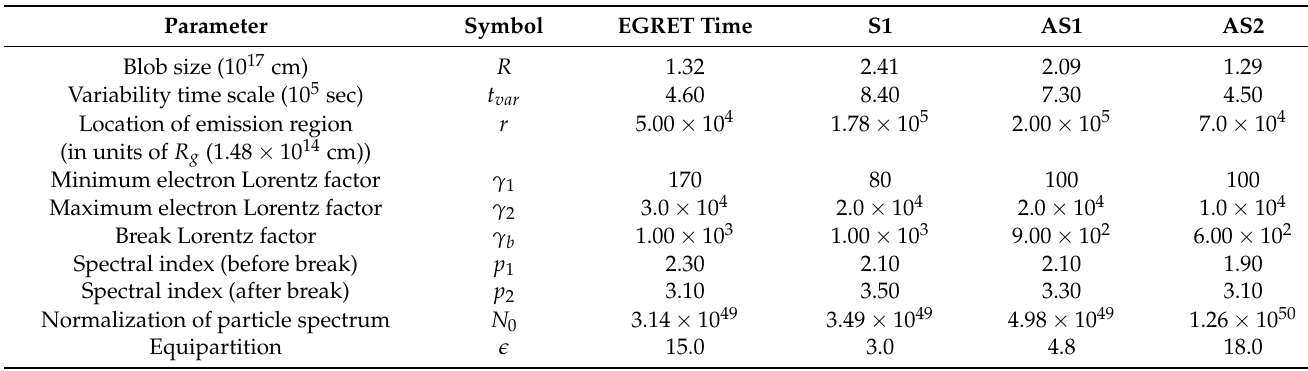
Table 6. Model parameters for the